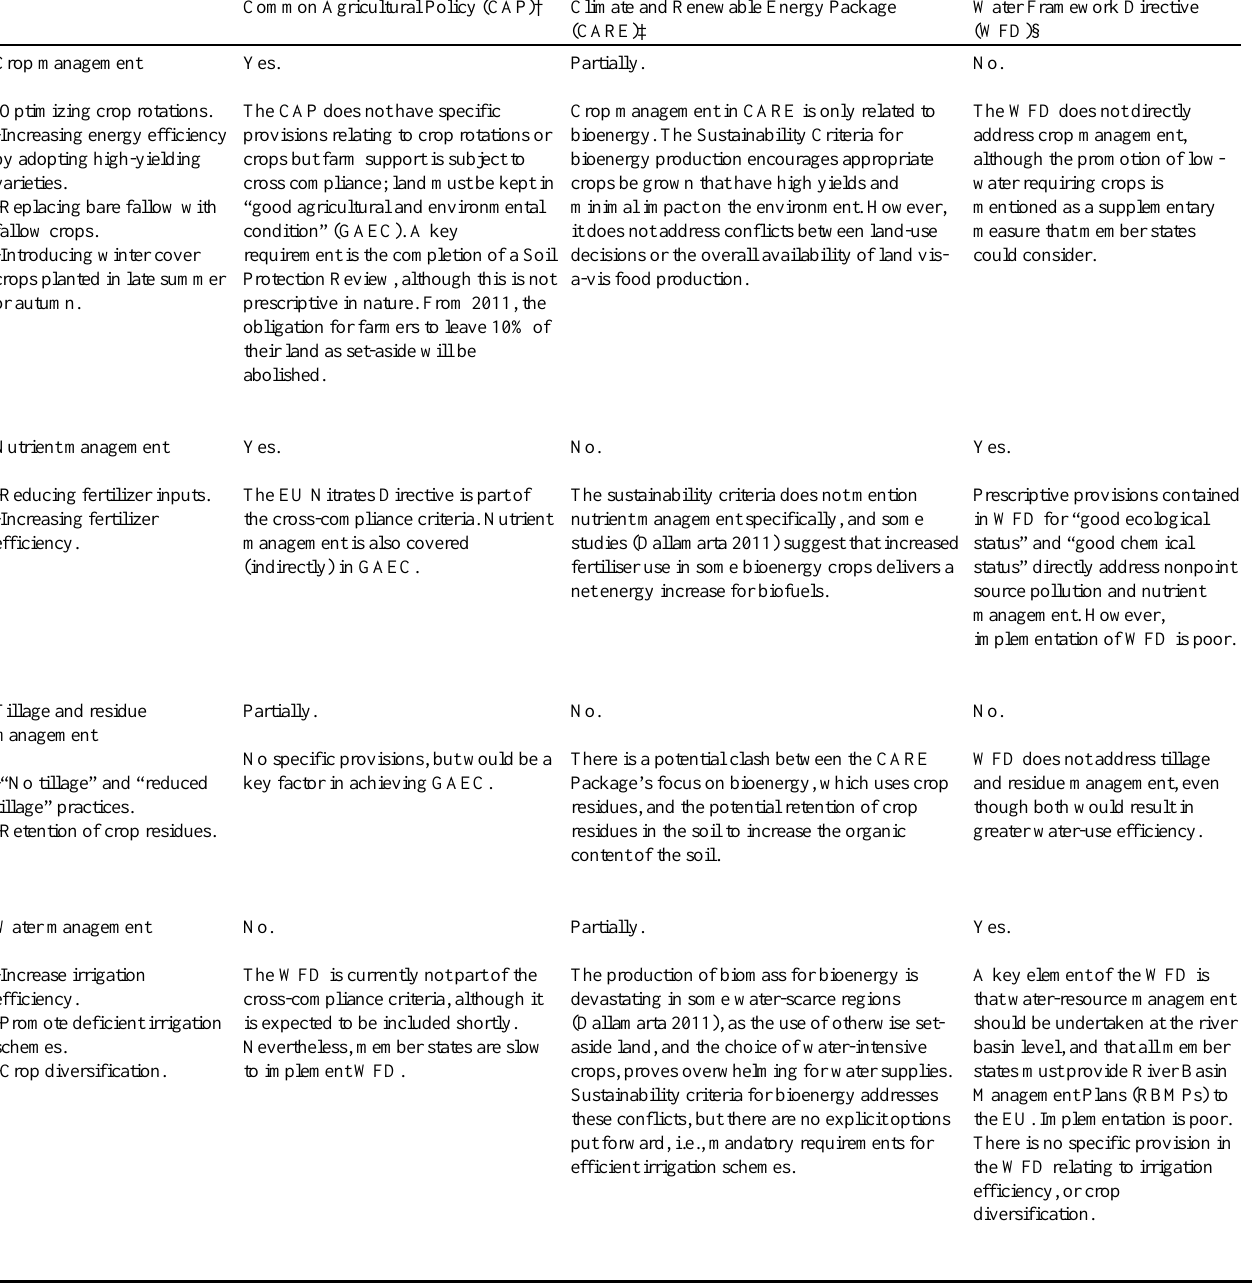
Table 2. Integration of GHG-mitigating soil-management strategies in key EU